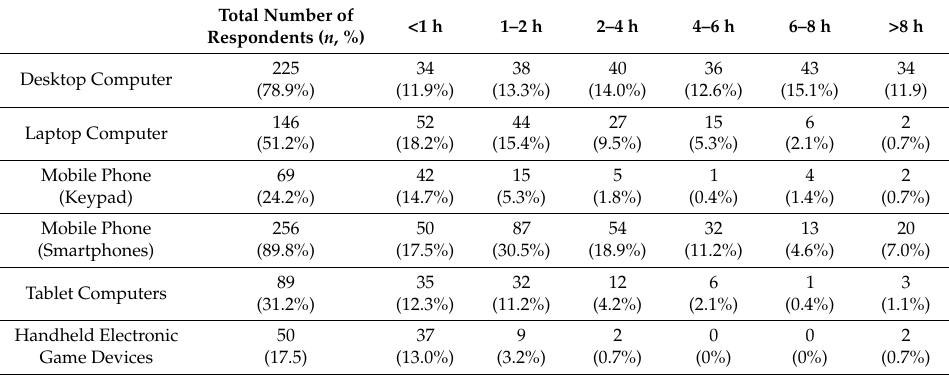
Table 2. Number of participants reporting daily use of various IT devices ( n = 285).